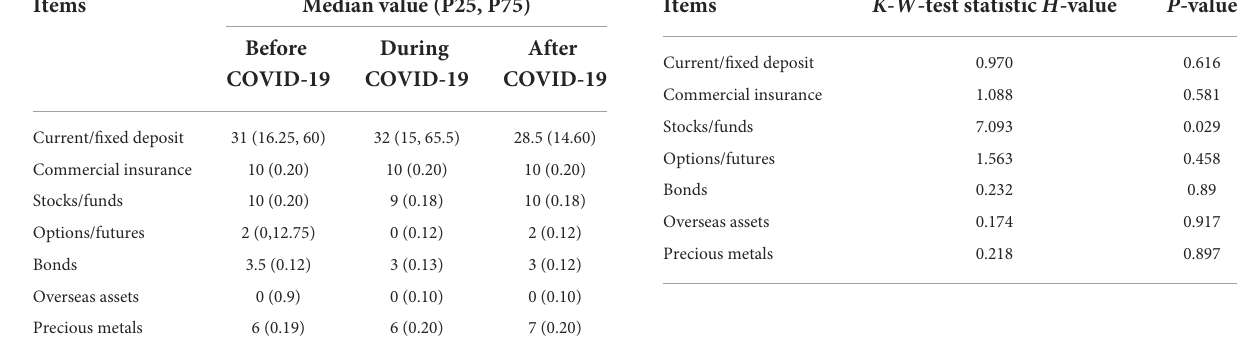
TABLE 7 Stock/fund class multiple